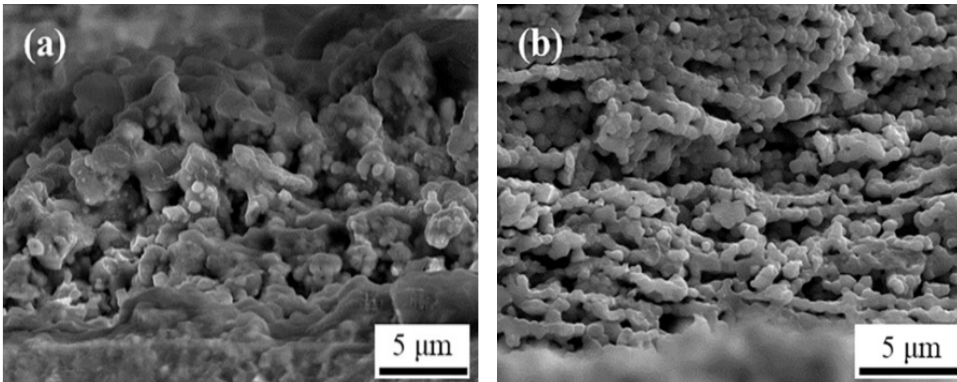
Figure 5. The as-sprayed cross-sectional morphology of the YSZ/LSM cathode and LSM cathode